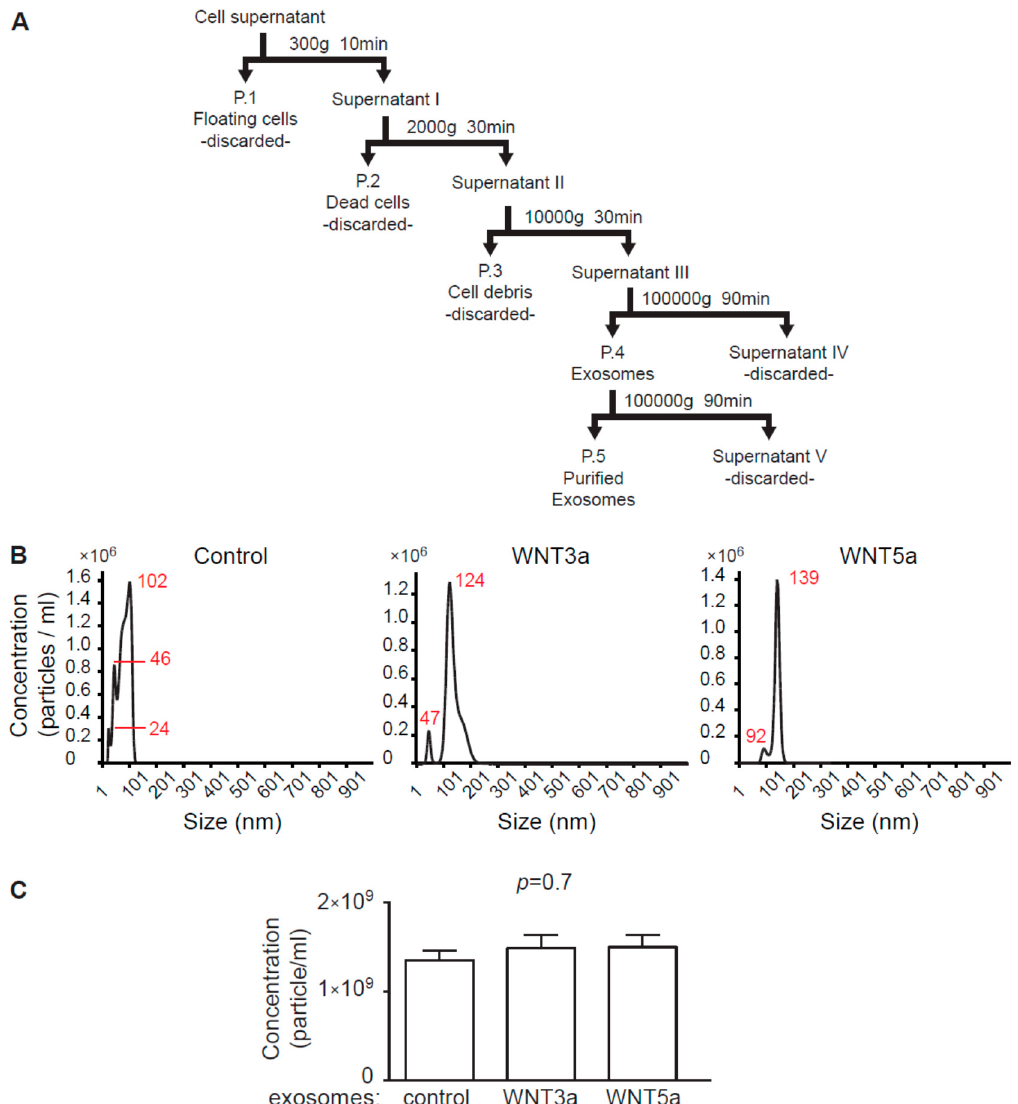
Figure 1. Isolation and nanoparticle tracking analysis (NTA) of exosomes isolated from cell culture supernatants. Panel ( A ) shows a scheme of the exosome isolation protocol. Supernatants of control L, L-WNT3a, and L-WNT5a cell lines cultured for 48 h in exosome-free medium were used to obtain exosomes by serial ultracentrifugations. Panel ( B ) shows representative NTA and panel ( C ) indicates the concentrations of purified exosome stocks (P.5) obtained from the indicated cell lines. Graphs show means ± SEM, n = 4, p value computed using one-way ANOVA.